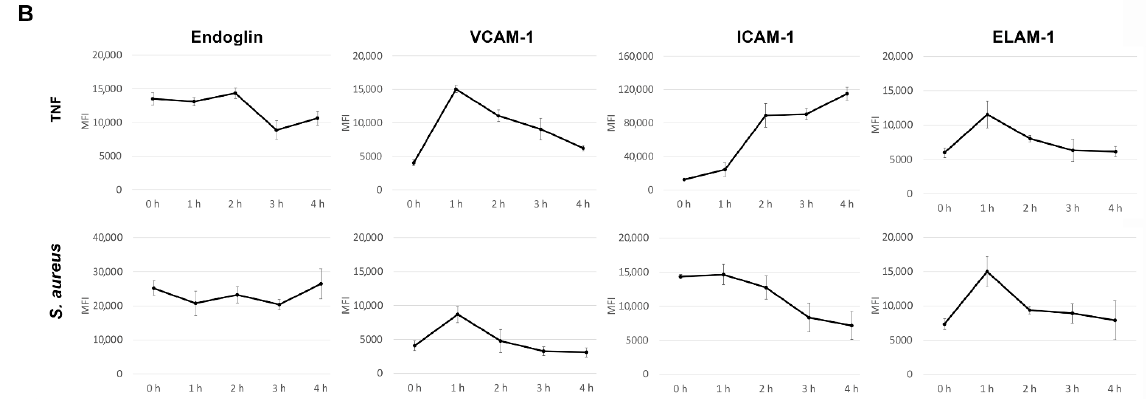
Figure 1. Flow cytometric analysis of adhesion molecules’ expression levels on the endothelial cell surface after incubation with TNF (25 ng/mL) and S. aureus 2879 M: ( A ) representative flow cytometry histograms for the endoglin, VCAM-1, ICAM-1, and ELAM-1 expression on the surface of EA.hy926 cells; ( B ) dynamics of endoglin, VCAM-1, ICAM-1 and ELAM-1 expression estimated using